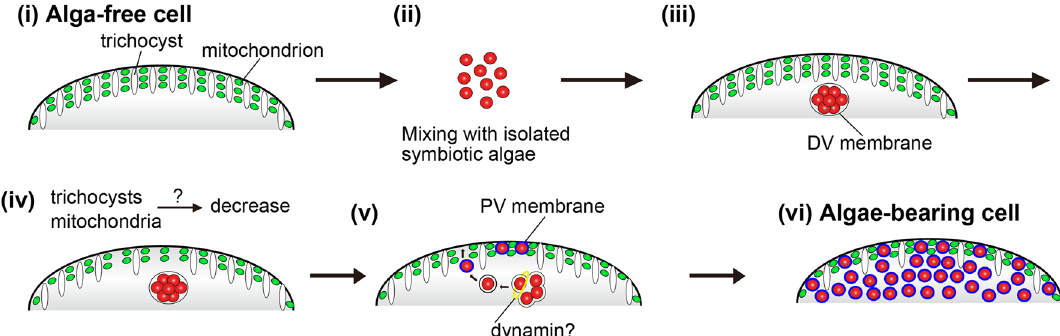
Figure 6. A schematic diagram of the algal attachment mechanism beneath the host cell cortex during the early alga reinfection. Before mixing with the symbiotic algae, many mitochondria and trichocysts were observed under the cell cortex of alga-free P. bursaria (i). After mixing with algae (ii), the algae are wrapped with the DV membrane (iii). (iv) Then, the trichocysts under the cell cortex are digested, as shown in our previous study 22 . Mitochondrial number may be decreased at the same timing. (v) The alga enclosed by the PV membrane moves toward the host cell cortex for attachment to the trichocyst and mitochondria-less area after the DV-budding related to dynamin 20 . (vi) Consequently, algal reinfection process was